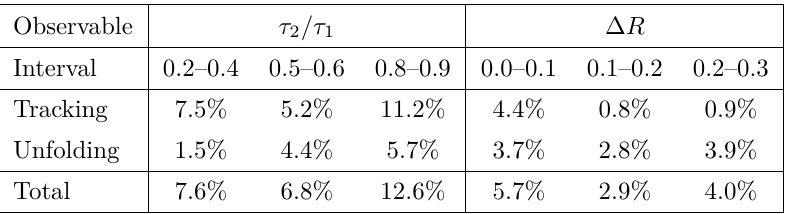
Table 1 . Relative systematic uncertainties of the measured observables, using k T reclustering, in √ pp collisions at s = 7 TeV are shown for three selected intervals of the observables in the jet p ch range of 40 – 60 GeV/ c . All sources of systematic uncertainty are considered to be uncorrelated.